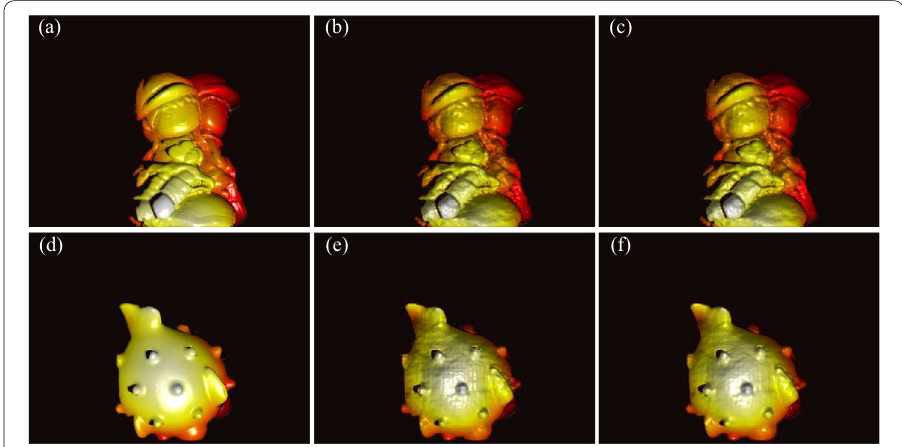
Fig. 3 3D reconstruction of different sculptures: a , d ground truth; b , e results of UNet; c , f results of the proposed